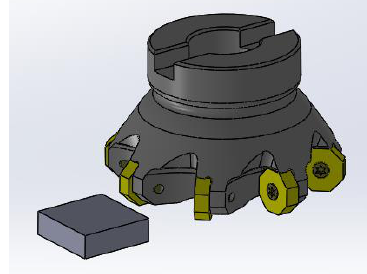
Fig. 1. Scheme of the tested